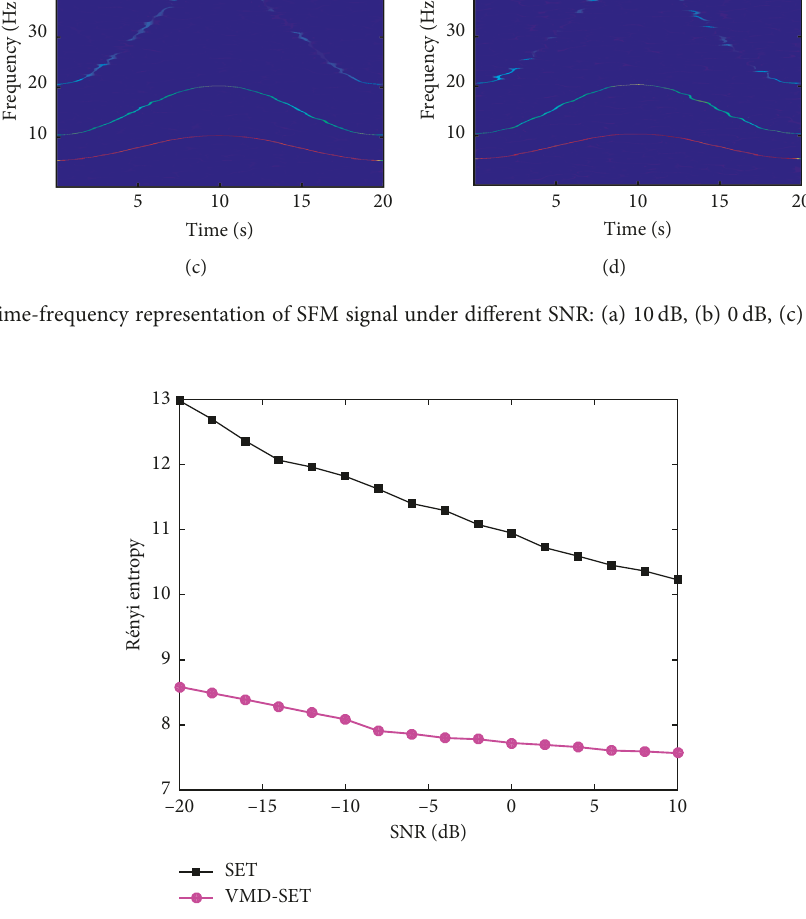
Figure 15: The R´enyi entropies of the time-frequency representation based on SET and VMD-SET under different SNR